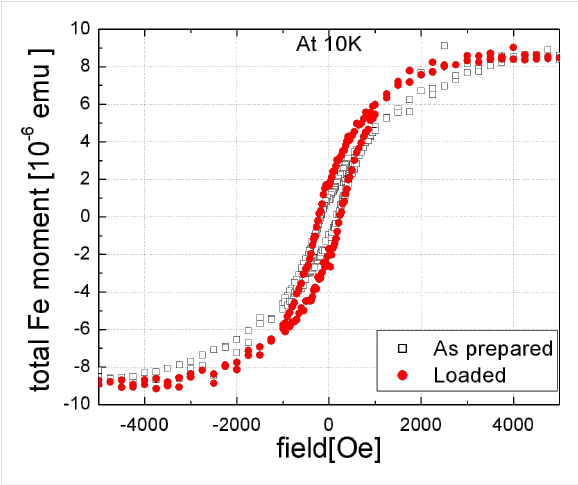
Figure 5: In-plane hysteresis curves of the embedded Fe nanoparti- cles measured at 10 K in as-prepared state (open squares) and after loading of the Ta substrate with H (red